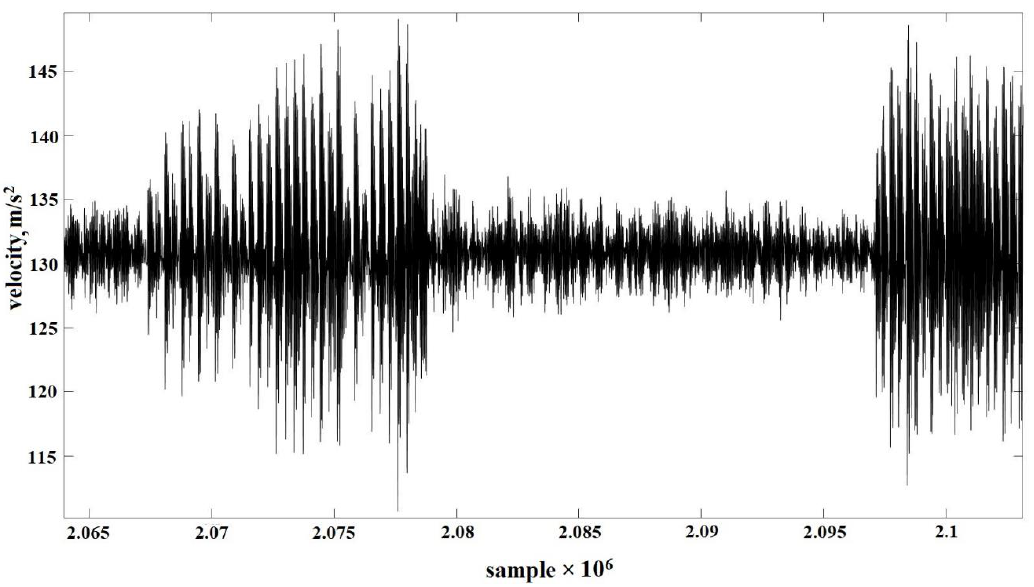
Figure 5. Measured vibration signal.